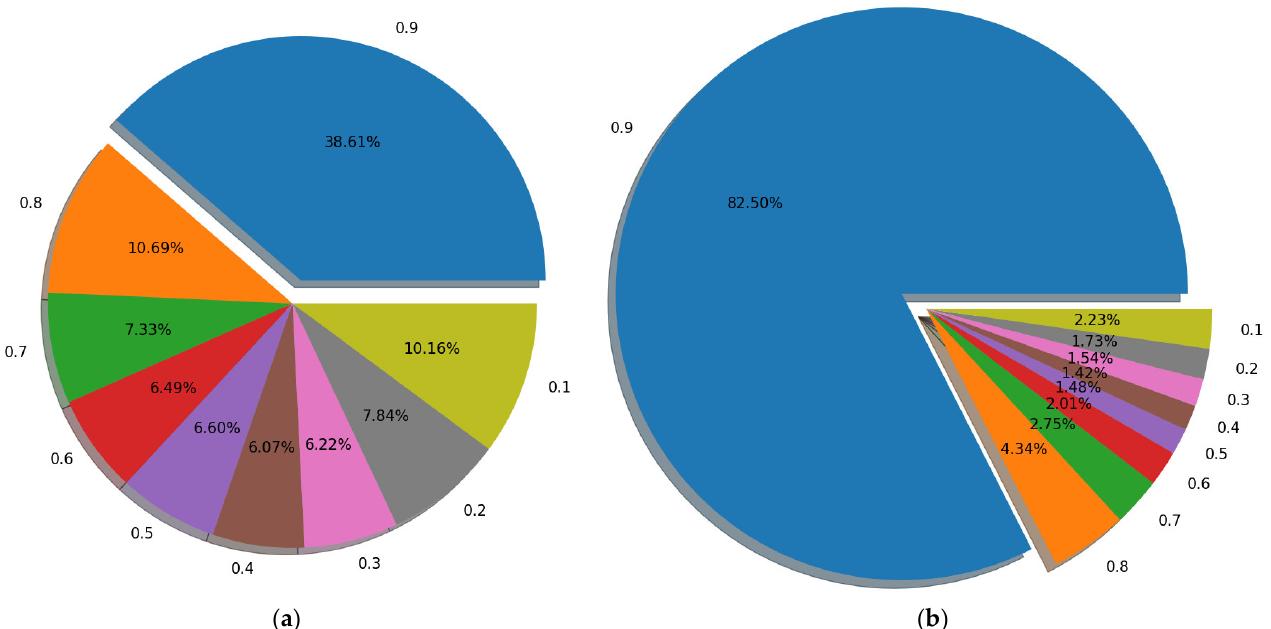
Figure 7. The difference between the predicted values of all image pairs after training. The goal of both networks is to return 1 to the image without rain and 0 to the image with rain. The number in the figure is the return value of the image without rain minus the return value of the image with rain. That is, the larger the difference is, the stronger the network’s discrimination ability is. As shown in the figure, on the image patches of 128 × 128, ViT [13] performs better than PatchGAN [47]. ( a ) PatchGAN [47] on 128 × 128 patches. ( b ) ViT [13] on 128 × 128